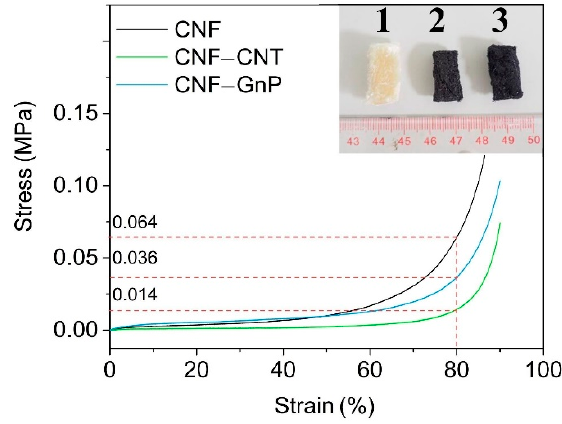
Figure 2. Stress–strain curves of CNF, CNF–CNT and CNF–GnP. The inset is a photograph of the freeze-dried aerogels. 1: CNF, 2: CNF–GnP and 3: CNF–CNT.